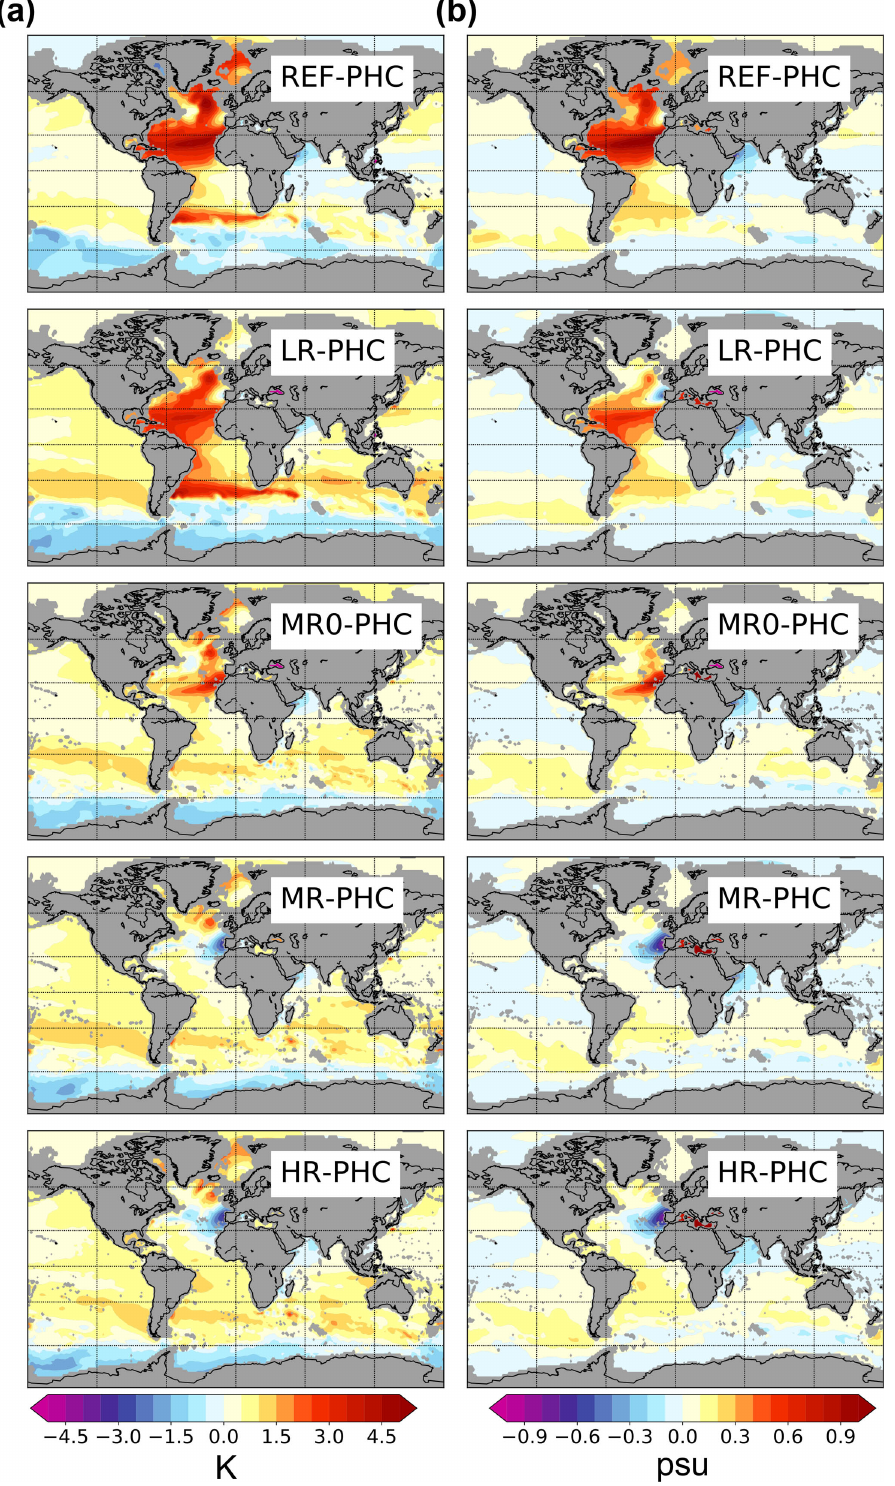
Figure 7. (a) Potential temperature [K] and (b) salinity [psu] biases with respect to PHC (PHC 3.0, updated from Steele et al., 2001) at 1000m depth, plotted on the observational grid. A systematic decrease of the temperature and salinity biases in the North Atlantic with increasing resolution (top to bottom) is